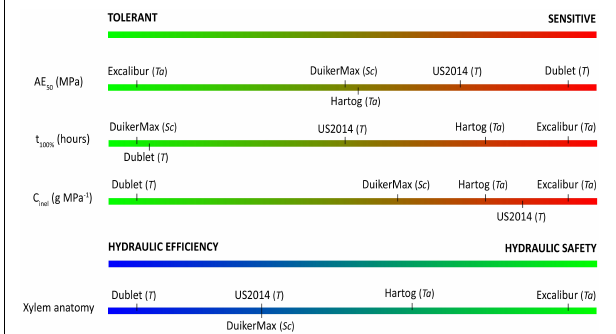
FIGURE 6 | Ranking of cultivars from tolerant to sensitive to drought stress, according to the different parameters explored in this study. Ta, T, and Sc indicate wheat ( T. aestivum L.), triticale (x Triticosecale Wittmack), or rye ( S. cereale